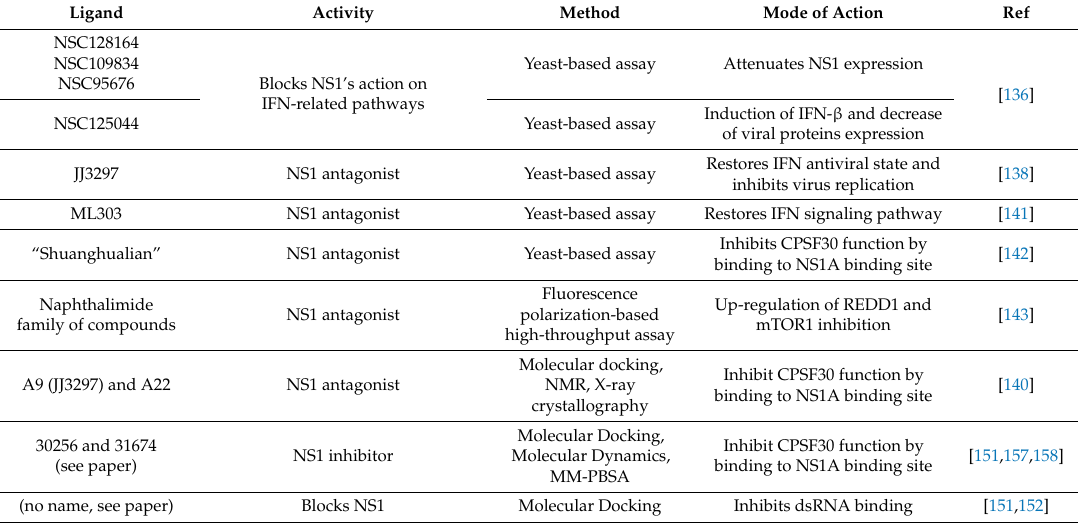
Table 2. Summary of studies exploring influenza’s NS1 as potential therapeutic